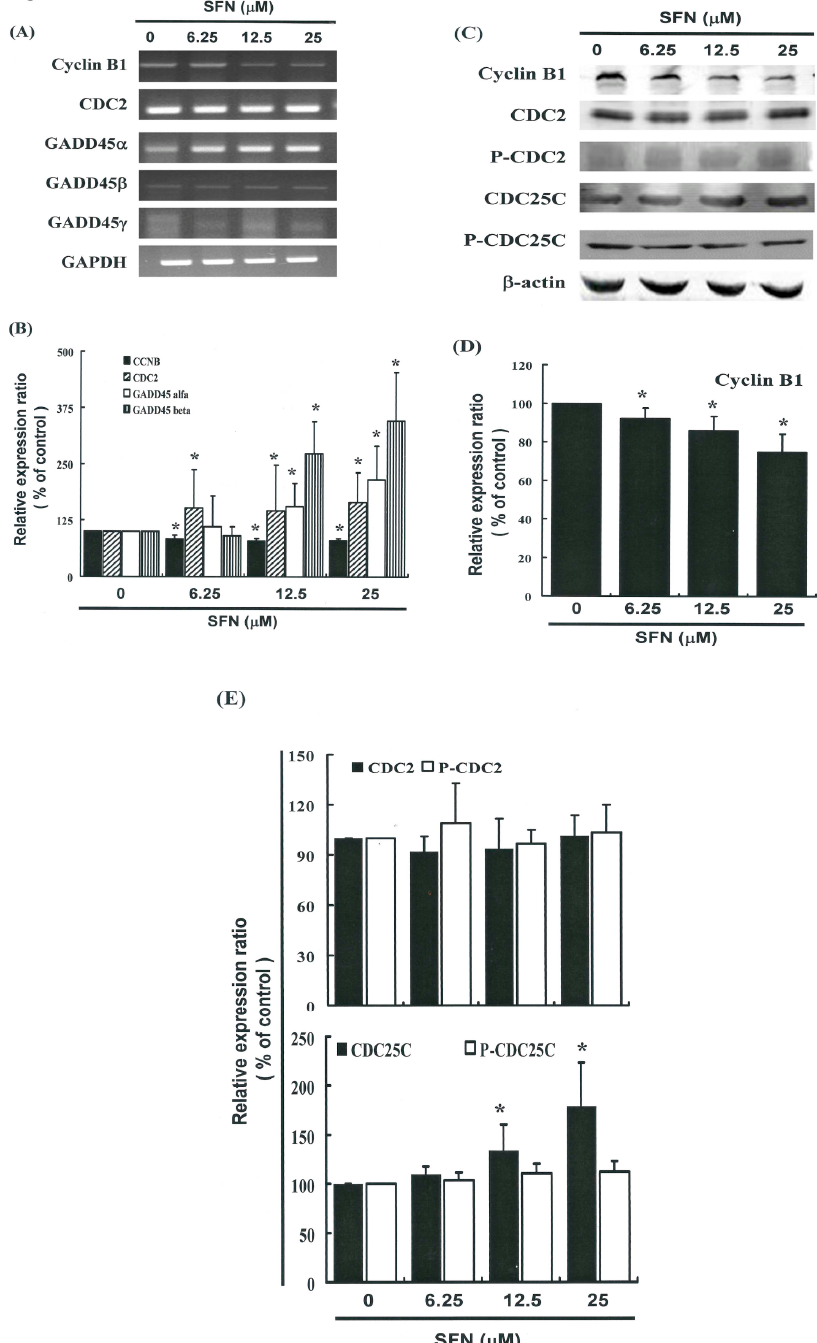
Figure 5. SFN represses cyclinB1 and up-regulates GADD45 β gene expression in HeLa cells. The cells were treated with SFN (0, 6.25, 12.5, and 25 μ M) for 24 hours, and gene expression was subsequently detected by RT-PCR, quantitative RT-PCR (qPCR) and Western blot analysis. ( A ) RT-PCR results for cyclin B1, CDC2 and, GADD45 family mRNAs in HeLa cells following exposure to SFN; ( B ) The panels show qPCR analysis of mRNA expression in cyclin B1, CDC2, GADD45- α , - β and - γ ; ( C ) Representative blot from 3 independent experiments; ( D , E ) Quantification of band intensities. All data is reported as the mean ( ± SEM) of at least three separate experiments. Statistical analysis was performed using a t -test, with differences considered significant at a level of * p < 0.05 versus the 0 µ M control group.